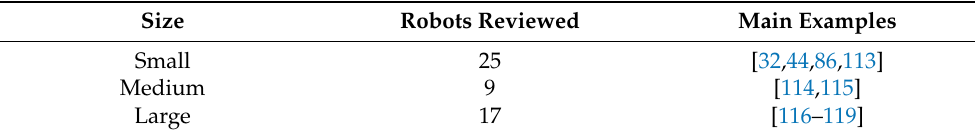
Table 2. Size of agricultural